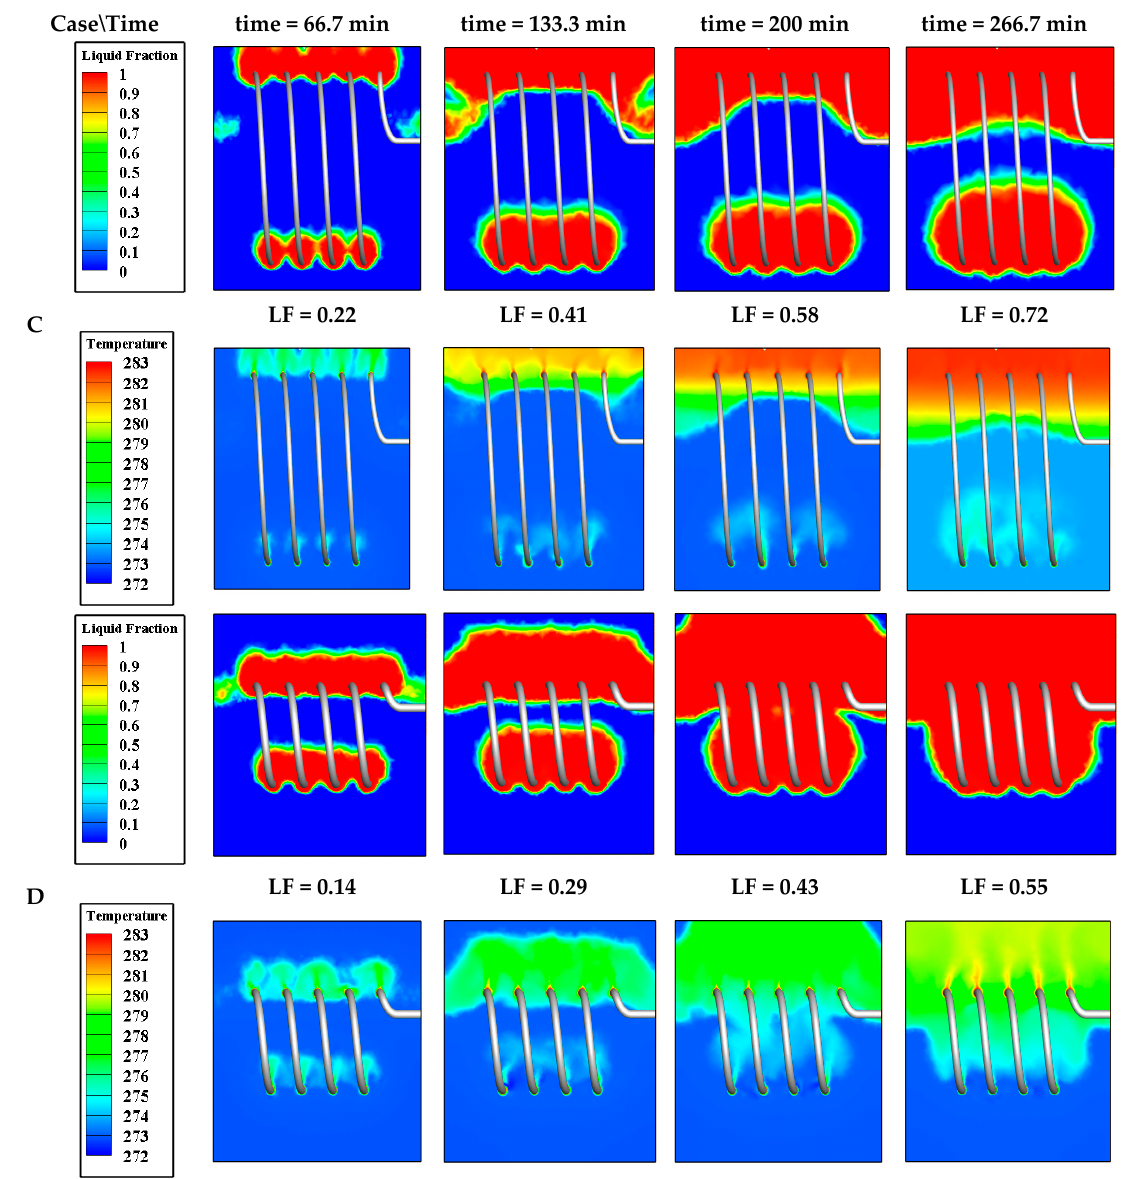
Figure 15. Contours of the liquid fraction and temperature for cases C and D at four di ff erent times in the plane x = 0.